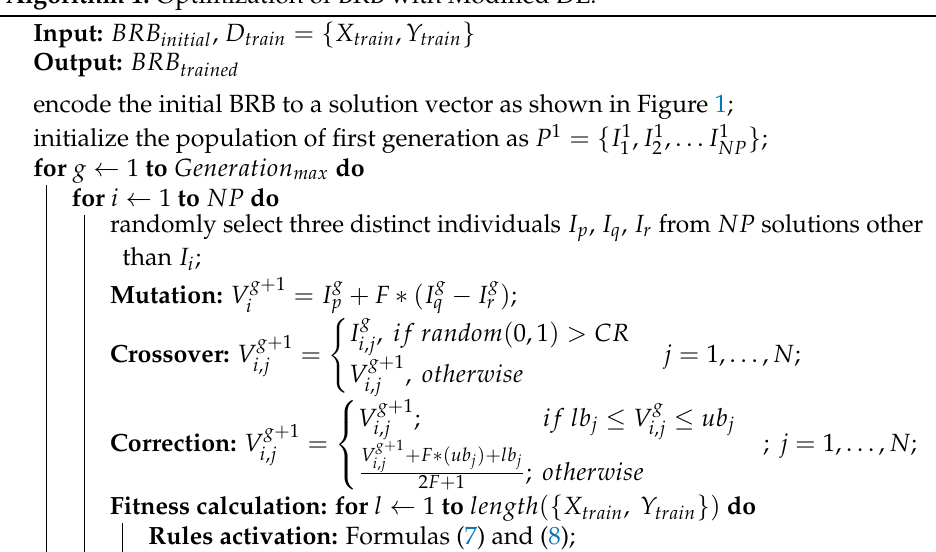
Algorithm 1: Optimization of BRB with Modified